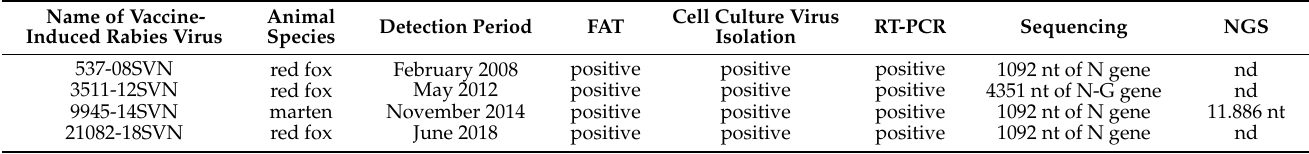
Table 1. Laboratory results of four vaccine-induced rabies cases from